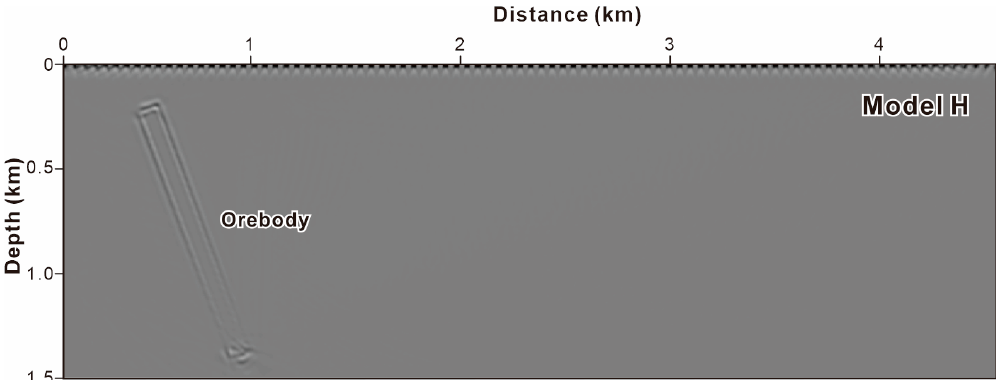
Figure 5. RTM imaging result of model H.